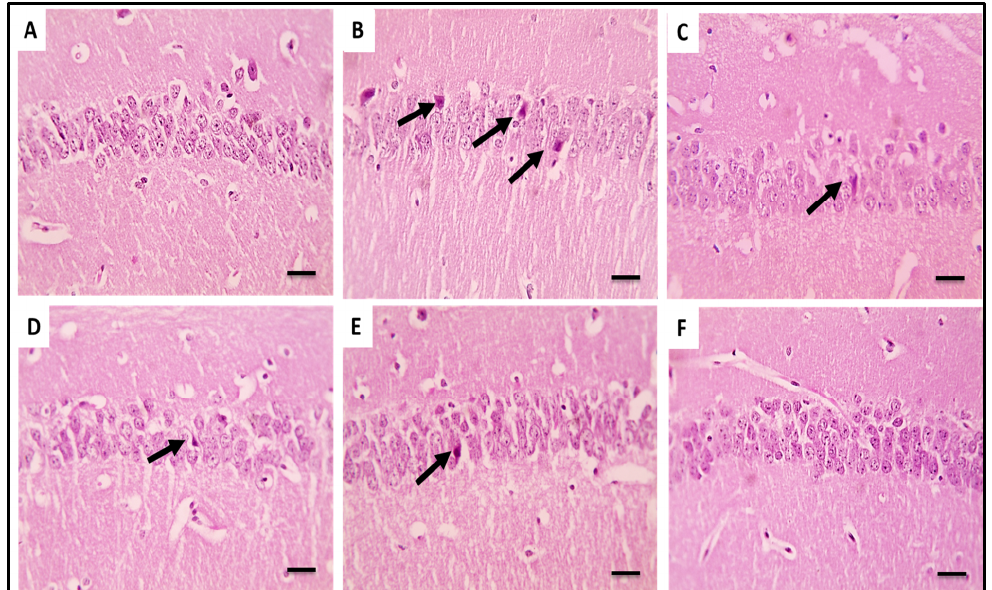
Figure 12. H&E-stained brain sections showing the hippocampus of the different groups. Normal neurons were revealed in the control group (group 1, ( A )). Sections from the group that received LPS (group 3, ( B )) showed the appearance of many degenerated neurons in the pyramidal layer (black arrows). Sections from the treated group with RVS (group 4, ( C )), SPE 100 mg/kg (group 5, ( D )), and SPE 200 mg/kg (group 6, ( E )) showed the presence of a few degenerated neurons in the pyramidal layer (black arrows). Sections from the treated group with SPE 300 mg/kg showed normal neurons in the pyramidal layer (group 7, ( F )) (×400).